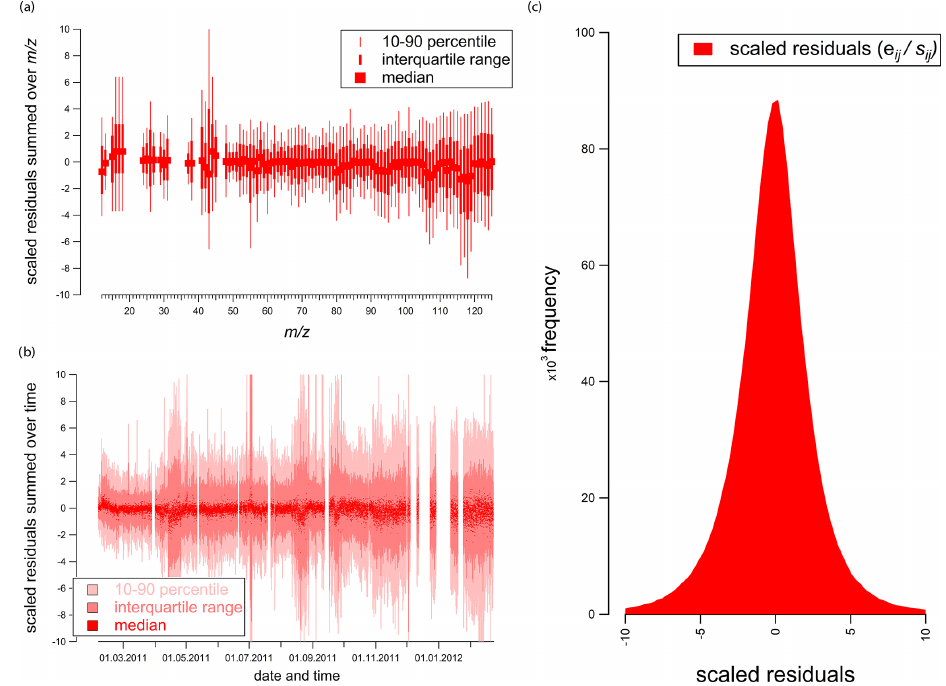
Figure 7. (a) Scaled residuals over m/z s, (b) scaled residuals over time and (c) total histogram of scaled residuals.